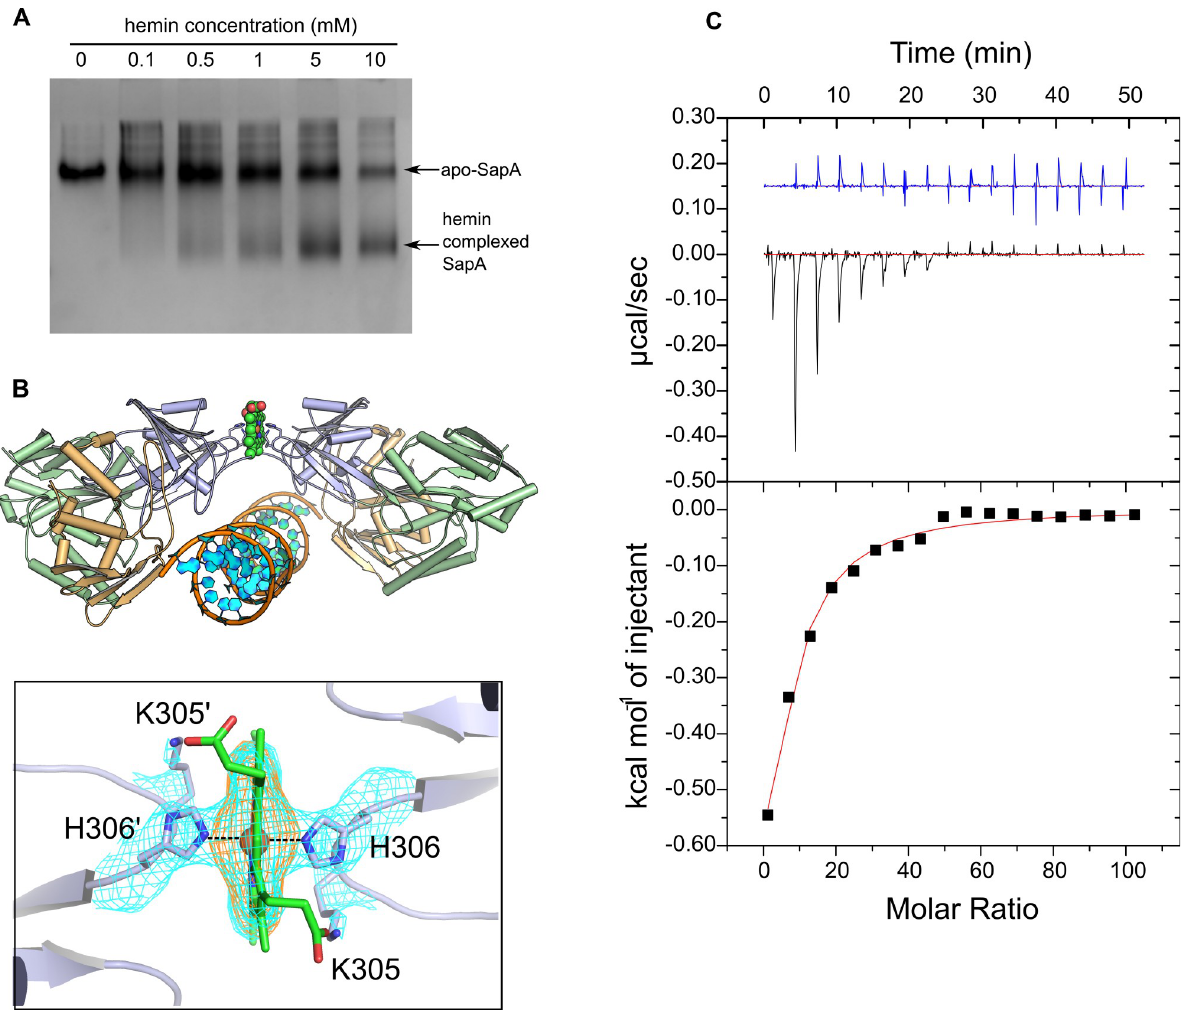
Fig 5. SapA interaction with heme. A, native gel assay for hemin interaction with SapA: Lanes 1–6 correspond to increasing concentrations of Hemin incubated with 5 μ g of SapA. B, Soaking of hemin into SapA crystals. Top panel: a spherical representation of a heme molecule coordinated on the interface of two symmetry-related copies of the SapA heme monomer. Bottom panel: the heme iron (orange sphere) is coordinated by His 306 (dashed line) from two symmetry mates. The meshes represent 2Fo-Fc (cyan) and Fo-Fc (orange) maps contoured at 1 and 3.5 σ respectively. C, isothermal titration calorimetry; Top panel: The experimental trace (black) obtained upon injection of hemin into SapA and into buffer control (blue). The baseline is indicated in red. Bottom panel: The integrated heats upon injection (black squares) and the data fit (red line) after subtraction of the control